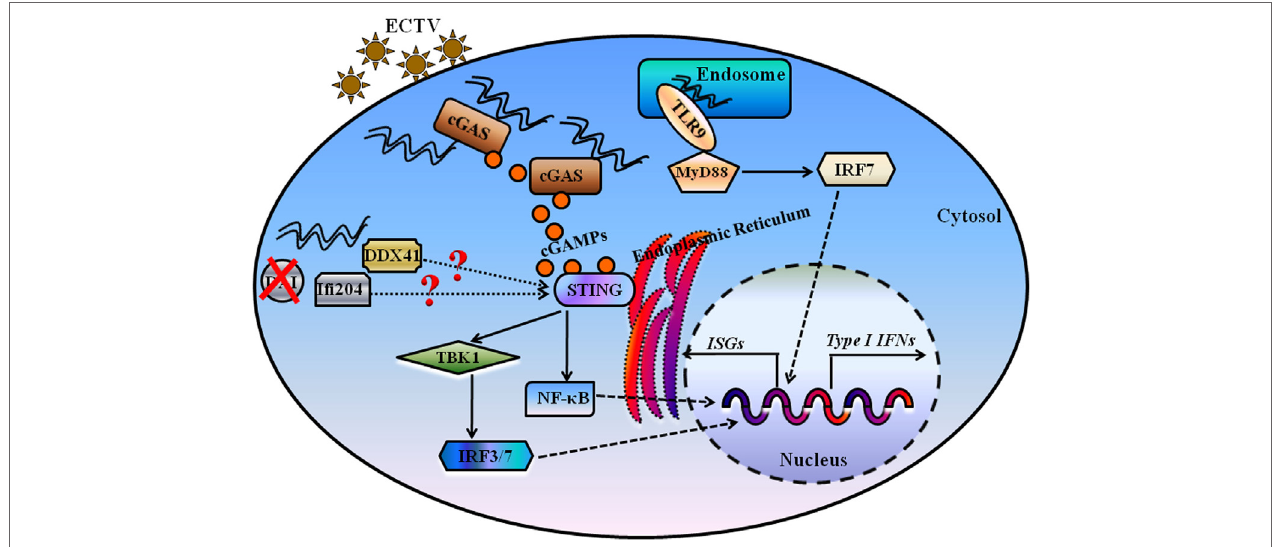
FigUre 9 | Proposed model for illustrating the essential roles of DNA sensors in recognition and innate interferons (IFNs) production during ectromelia virus (ECTV) infection. Upon viral entry, some of ECTV virions are processed in the endosome, and viral DNA is firstly detected by Tlr9, which signals through the Myd88–Irf7 axis to promote expression of type I IFNs. Moreover, some of viral DNA is detected by the cytosolic DNA sensor cGas, and cGas catalyzes the formation of cGMP-AMP (cGAMP), which through the Sting–Tbk1–Irf3/7 axis leads to the activation of IFN responses. Other cytosolic DNA sensors, including Ifi204 and Ddx41, potentially recognize viral DNA present in the cytoplasm for the activation of IFN responses. DAI, one of the receptors upstream of Sting, has been ruled out as the critical DNA sensor for the activation of IFN responses during an ECTV